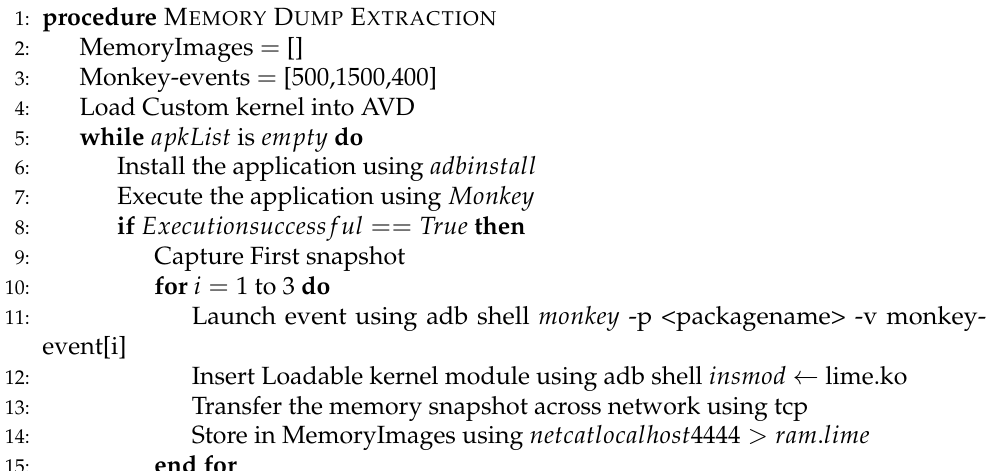
Algorithm 1 Algorithm used by KTSODroid for feature